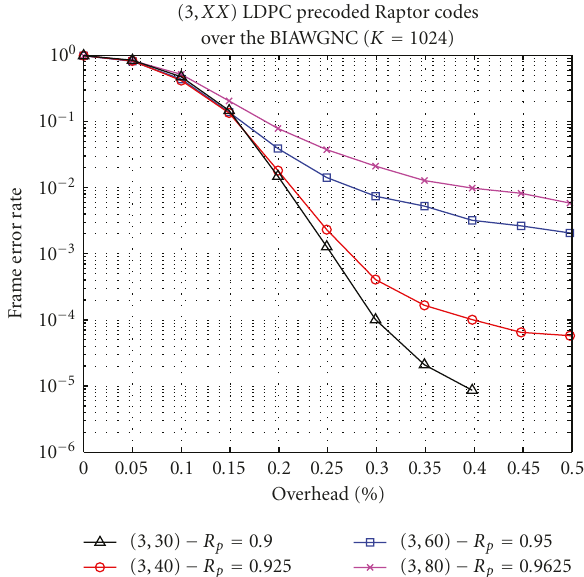
Figure 7: Performance of LDPC precoded Raptor codes of size K = 1024. Only the lowest considered rate R p = 0 . 9 shows good performance. For all other precode rates, the code exhibits an error floor, which can be explained by the large number of small cycles in the precode Tanner graphs.